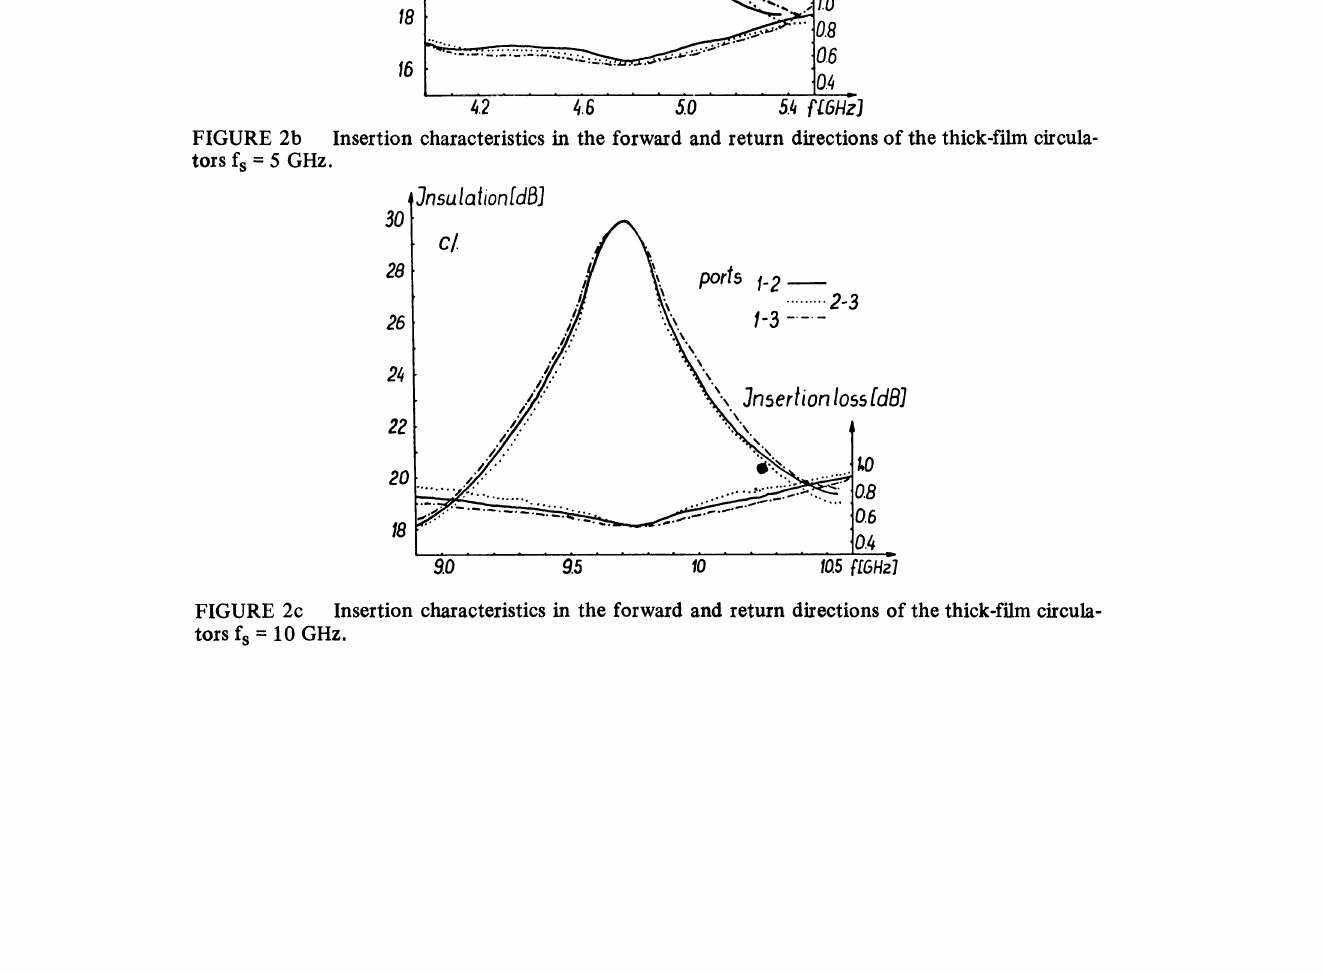
FIGURE 2b tots fs 5 GHz.